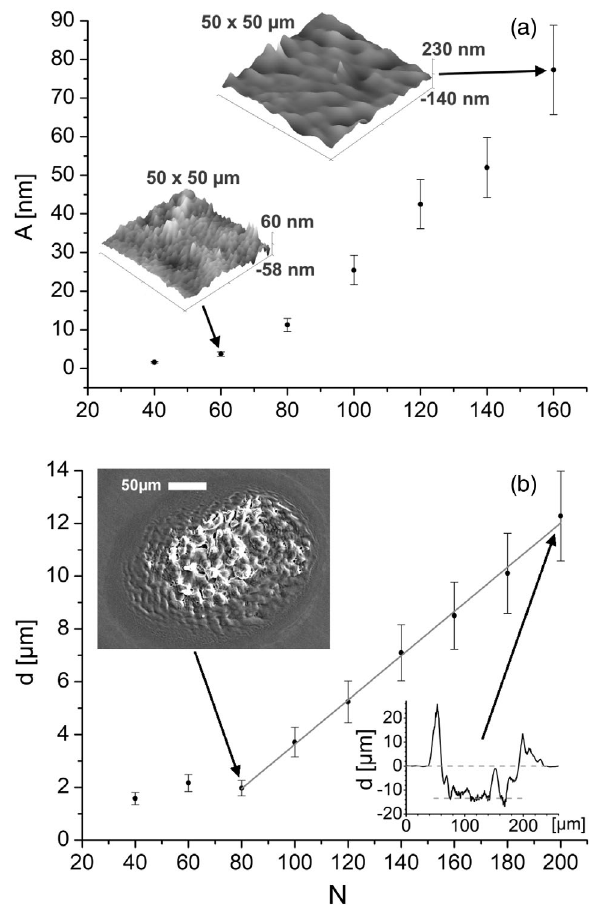
FIG. 4. (a) Amplitude of the dominating waves (averaged over ca. 20 different wave fronts), A , vs pulse number N for a laser fluence of 0 . 68 J = cm 2 as determined from AFM micrographs. Two representative AFM micrographs ( 50 × 50 μ m) correspond- ing to the data at two different points are presented in the insets in (a). (b) Ablation depth d vs the pulse number for a laser fluence of 2 . 89 J = cm 2 as determined with OP. The insets in (b) show the shape of the crater as determined by SEM after 80 pulses and the crater profile after 200 pulses as determined by OP. The dashed lines emphasize the reference planes for the determination of the ablation depth.